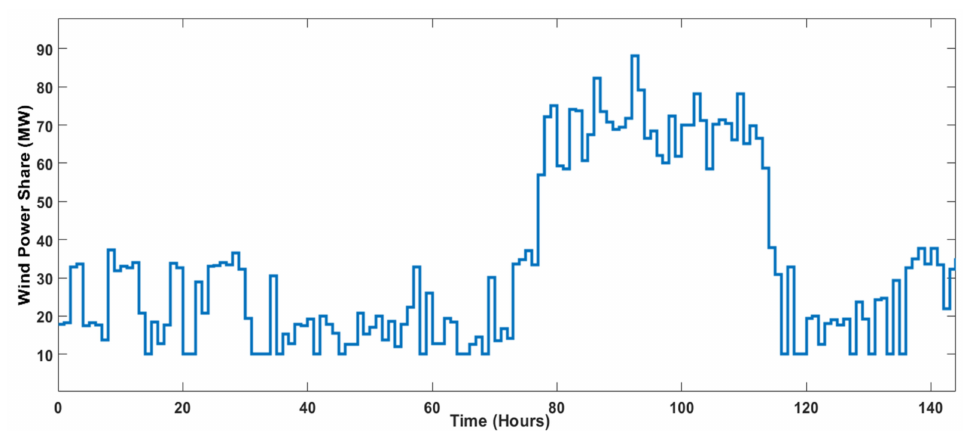
Figure 8. Load power demand.